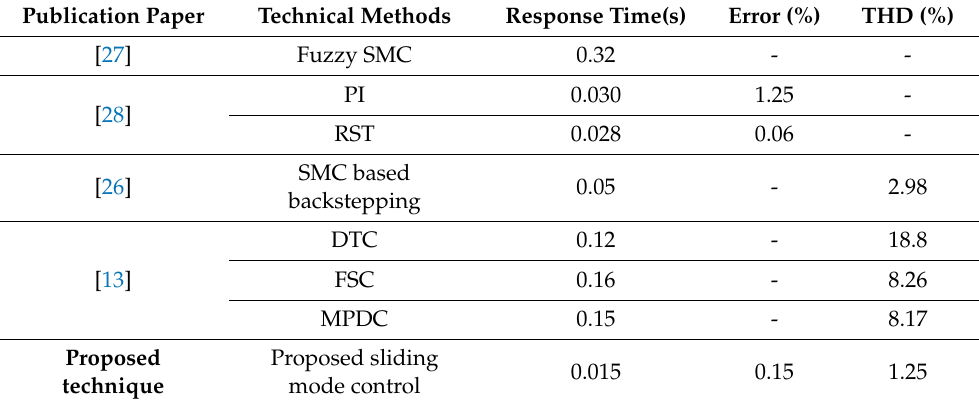
Table 1. Comparison with technical